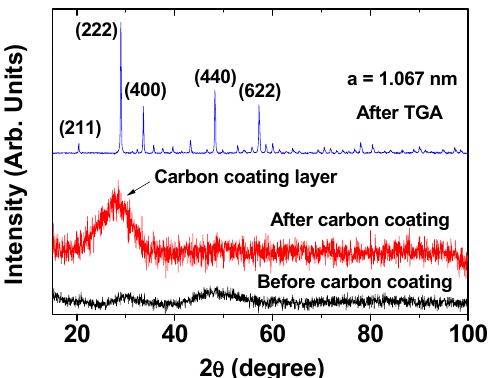
Figure 2. XRD patterns of the DYO nanoparticles before carbon coating (bottom spectrum), and DYO@C nanoparticles before TGA (middle spectrum) and after TGA (top spectrum). All peaks after TGA could be assigned with (hkl) Miller indices corresponding to cubic Dy 2 O 3 and only the strong peaks were assigned. Table 1. Summarized properties of DYO@C nanoparticles.